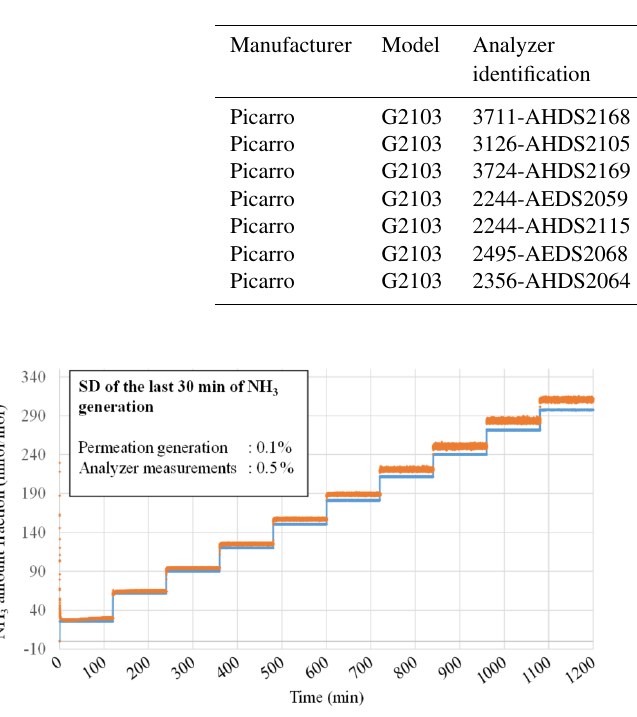
Table 10. Calibration results (slope, intercept, and correlation coefficient) determined by LNE for seven NH 3 analyzers used by four French networks at monitoring stations.